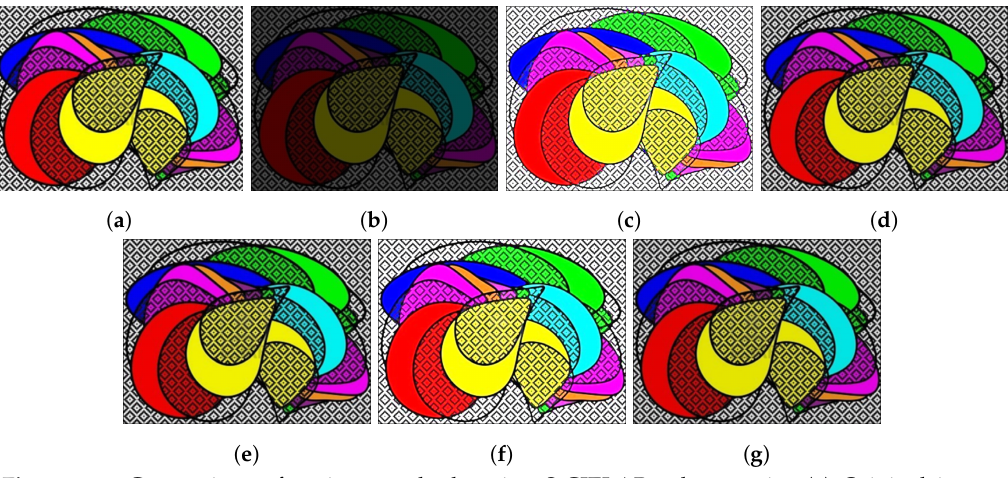
Figure 11. Comparison of various methods using S-CIELAB color metric: ( a ) Original image; ( b ) Shadow version of the original image; ( c ) Image enhancement by sparse coding; ( d ) Image enhancement by single image CSC; ( e ) Image enhancement by single image SVD-CSC; ( f ) Image enhancement by large data CSC; ( g ) Image enhancement by large data